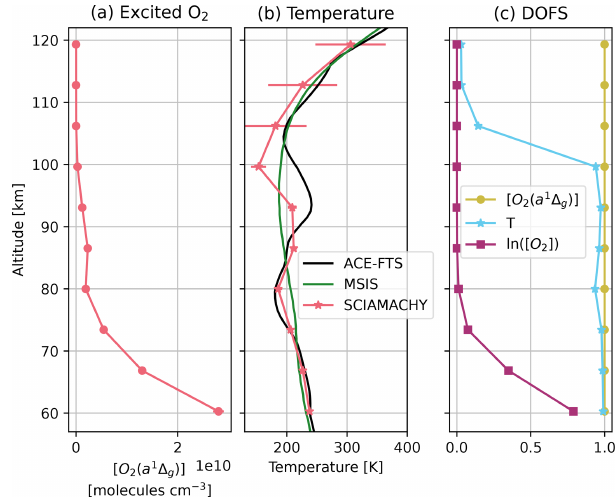
Figure 5. Similar to Fig. 3 but using an MLT vertical